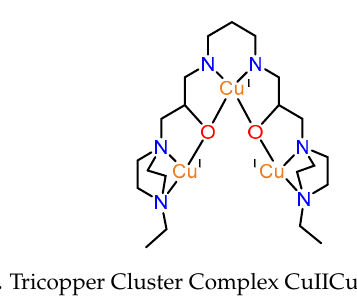
Figure 25. Preparation of MCM-41-1, 10-phen–CuI. Reproduced with permission from [33] . Copyright